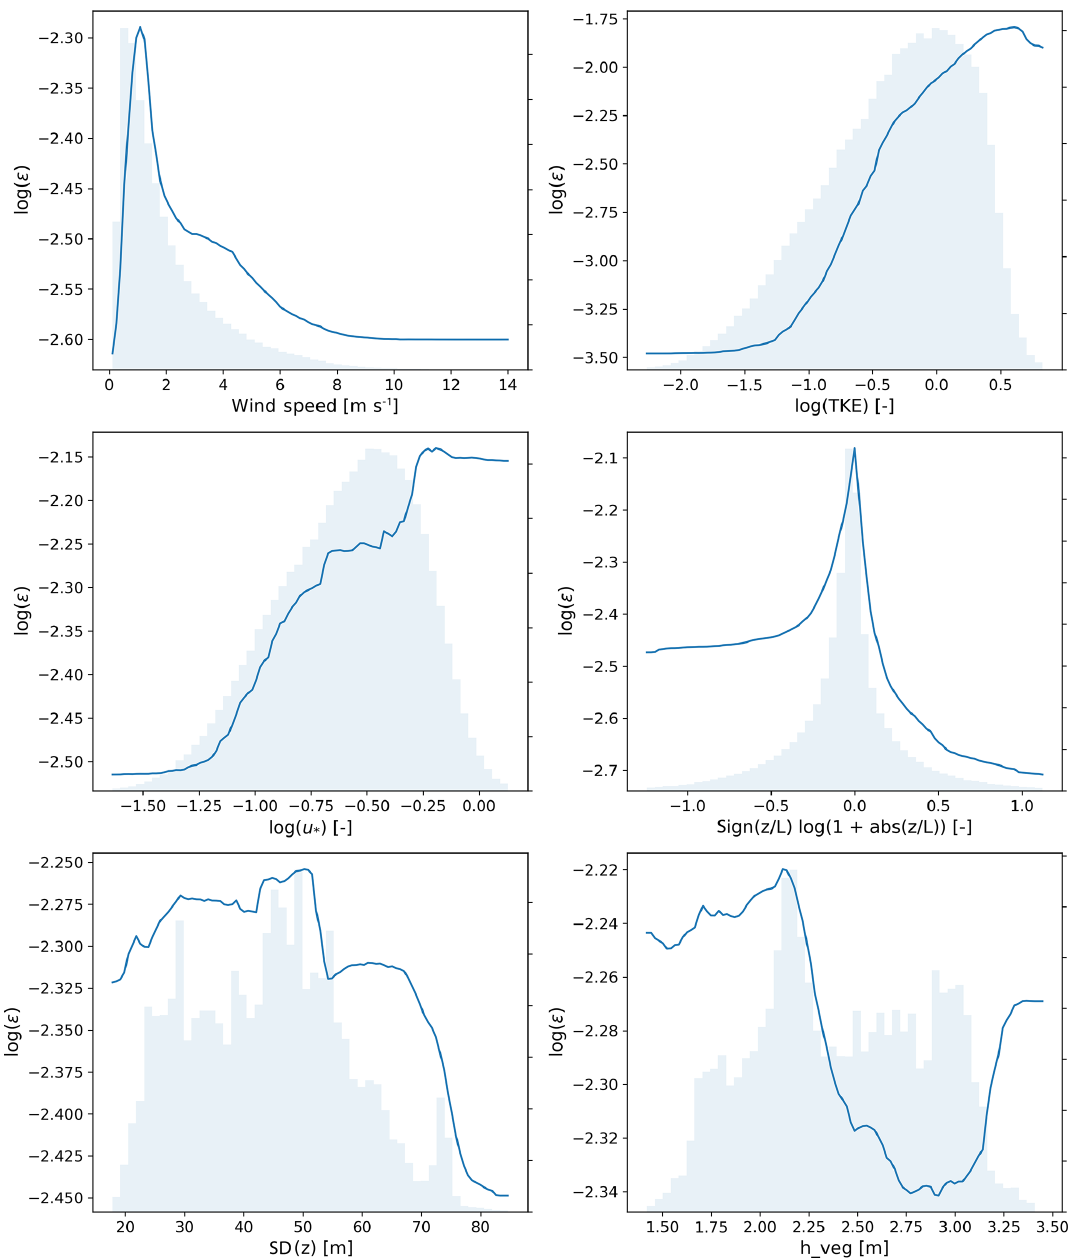
Figure 10. Partial dependence plots for the input features used in the analysis. Distributions of the considered features are shown in the